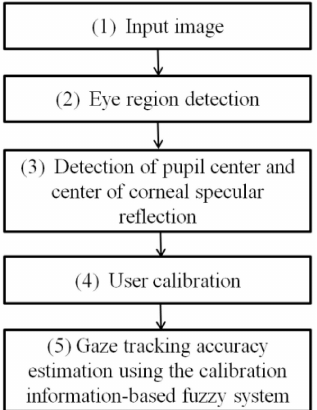
Figure 1. Flowchart of user calibration-information based gaze tracking estimation